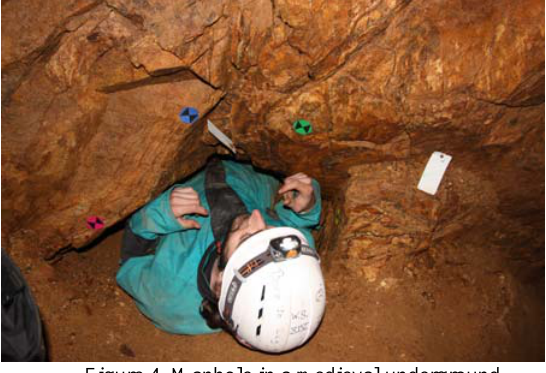
Figure 4. Manhole in a medieval underground